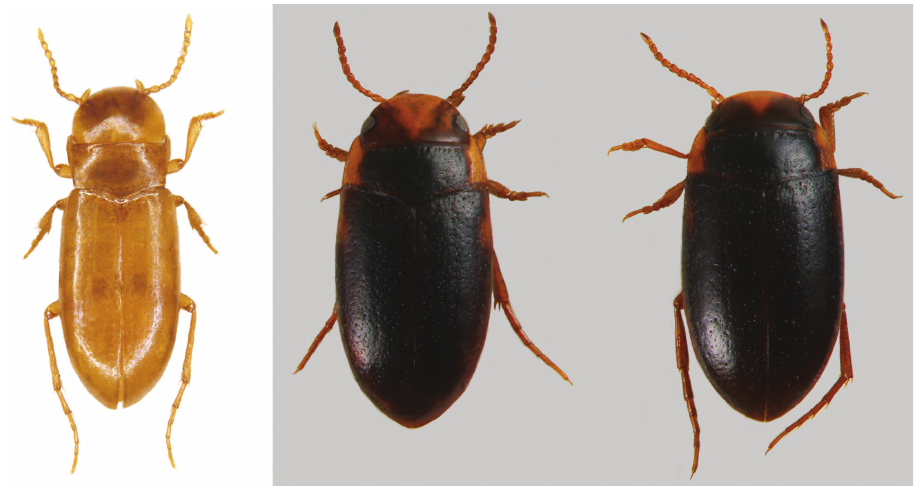
Figure 5. Habitus of the species of Iberoporus . a I. cermenius (modified from Millán et al. 2014) b I. agnus comb. n. c I. argaensis comb. n. (both modified from Fery